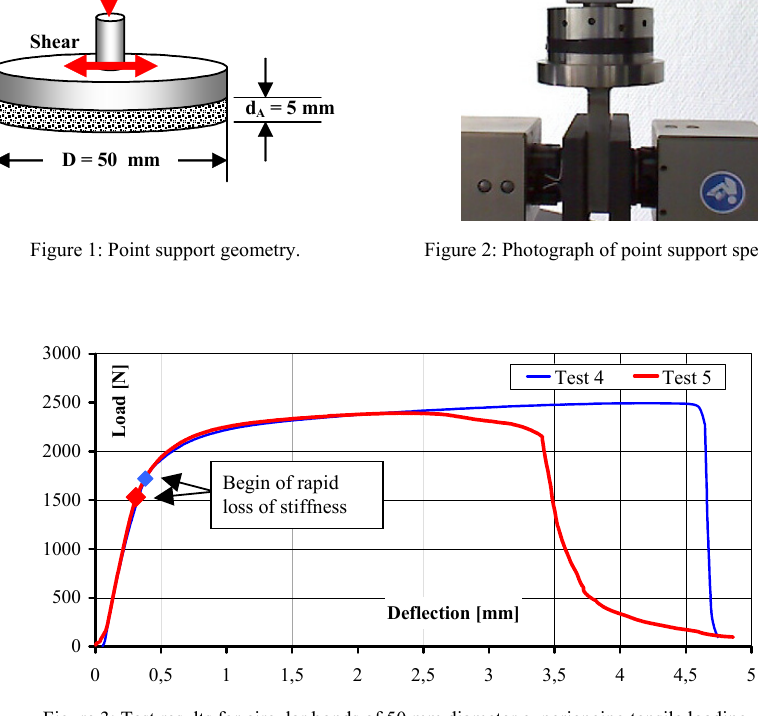
Figure 3: Test results for circular bonds of 50 mm diameter experiencing tensile loading.